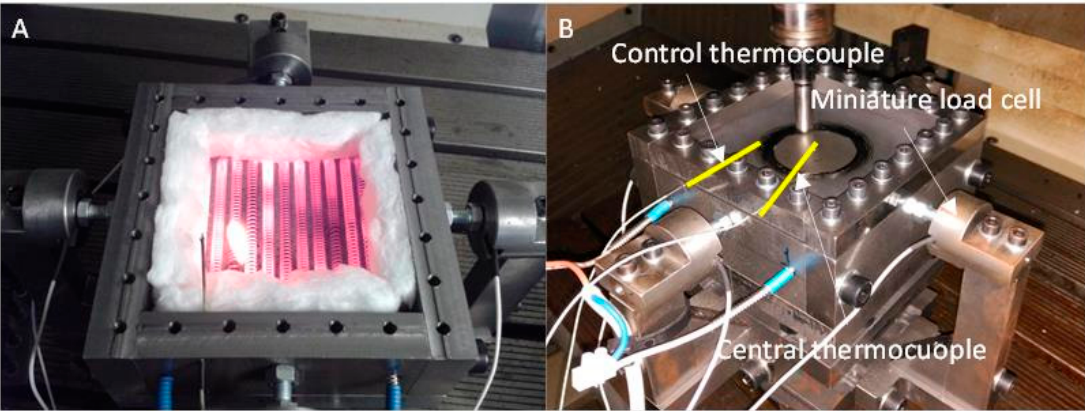
Figure 1. ( A ) Heated holding fixture for the Single Point Incremental Forming SPIF process. ( B ) Location of the load cells and thermocouples.